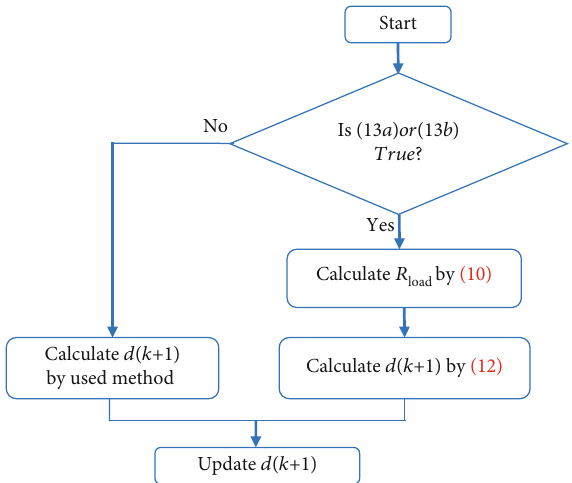
Figure 14: Flowchart of the proposed